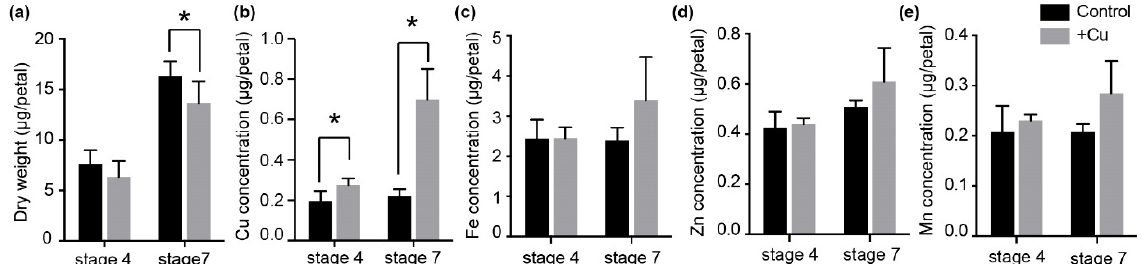
Figure 1. Dry weight and element concentrations in stage 4 and stage 7 petunia petals in plants that were unexposed (Control), or exposed to 40 μ M Cu (+Cu). ( a ) Dry weight of stage 4 and stage 7 petal upon exposure to excess Cu. Bars are mean ± SD ( n = 6). ( b ) Cu, ( c ) Fe, ( d ) Zn and ( e ) Mn content in petunia petals under excess Cu. Bars represent mean ± SD ( n = 4×3 petals). * indicates significant differences by Tukey’s HSD test ( p < 0.05).